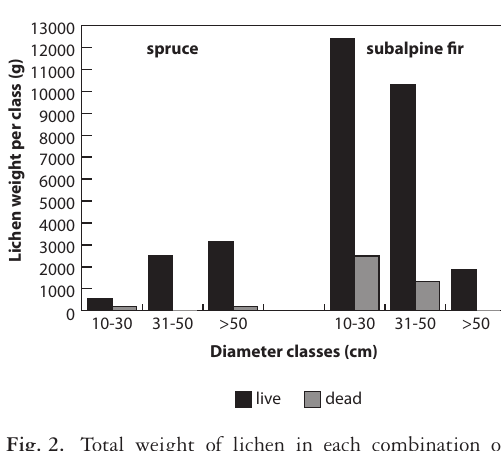
Fig. 2. Total weight of lichen in each combination of species, decay class and diameter class based on 1225 sample trees from all sites and treatments (1993).